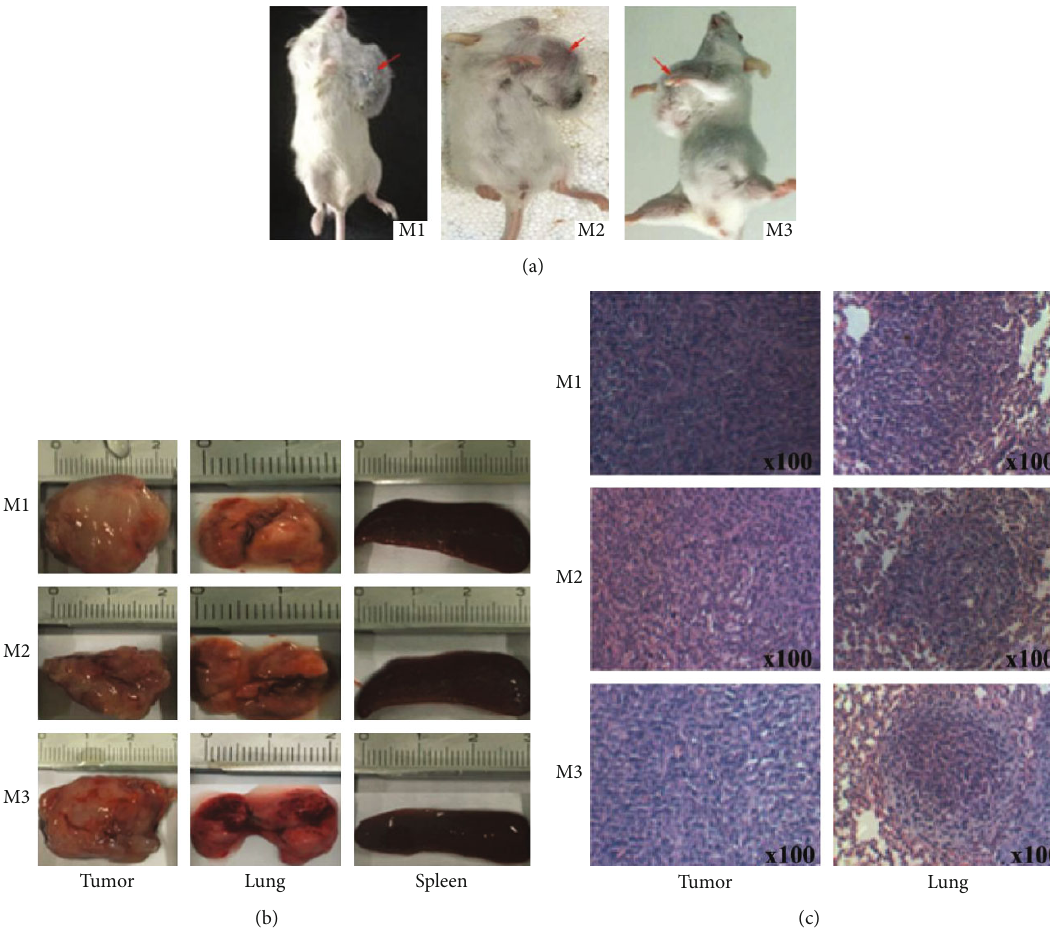
Figure 1: Three 4T1 tumor-bearing BALB/c mice (a) and the collection of samples of breast tumor tissues, metastatic lung tissues, and spleens (b) and pathological sections of HE staining of breast tumor tissues and lung metastatic tissues